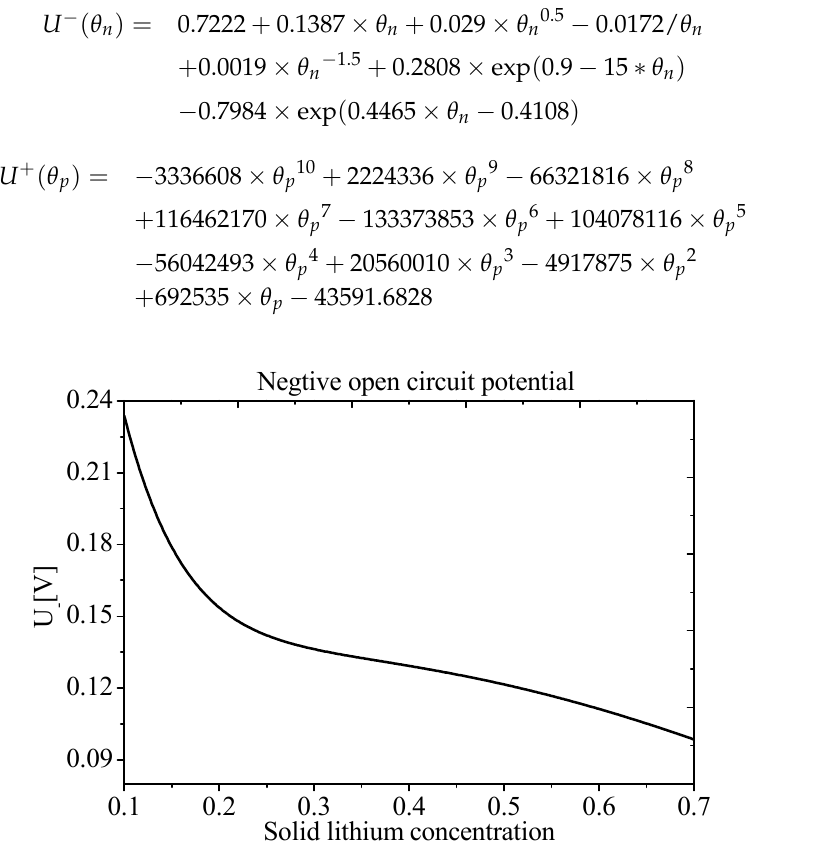
Figure 4. Negative open circuit potential.